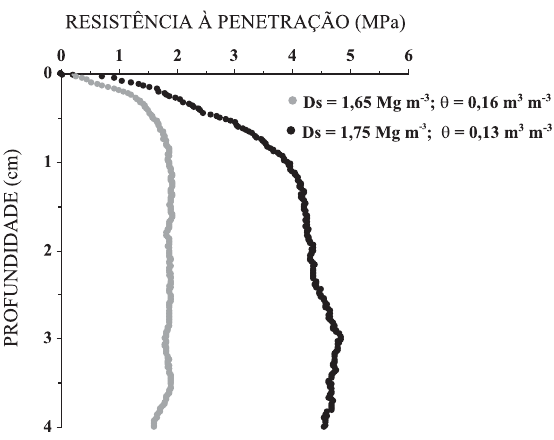
Figura 6. Distribuição da resistência à penetração em duas amostras indeformadas (5 cm de diâmetro e altura) de um Argissolo Vermelho-Amarelo distrófico, textura franco-arenosa, para diferentes condições de teor de água ( θθθθθ ) e densidade do solo (Ds). (N ≈ ≈ ≈ ≈ ≈ 240).